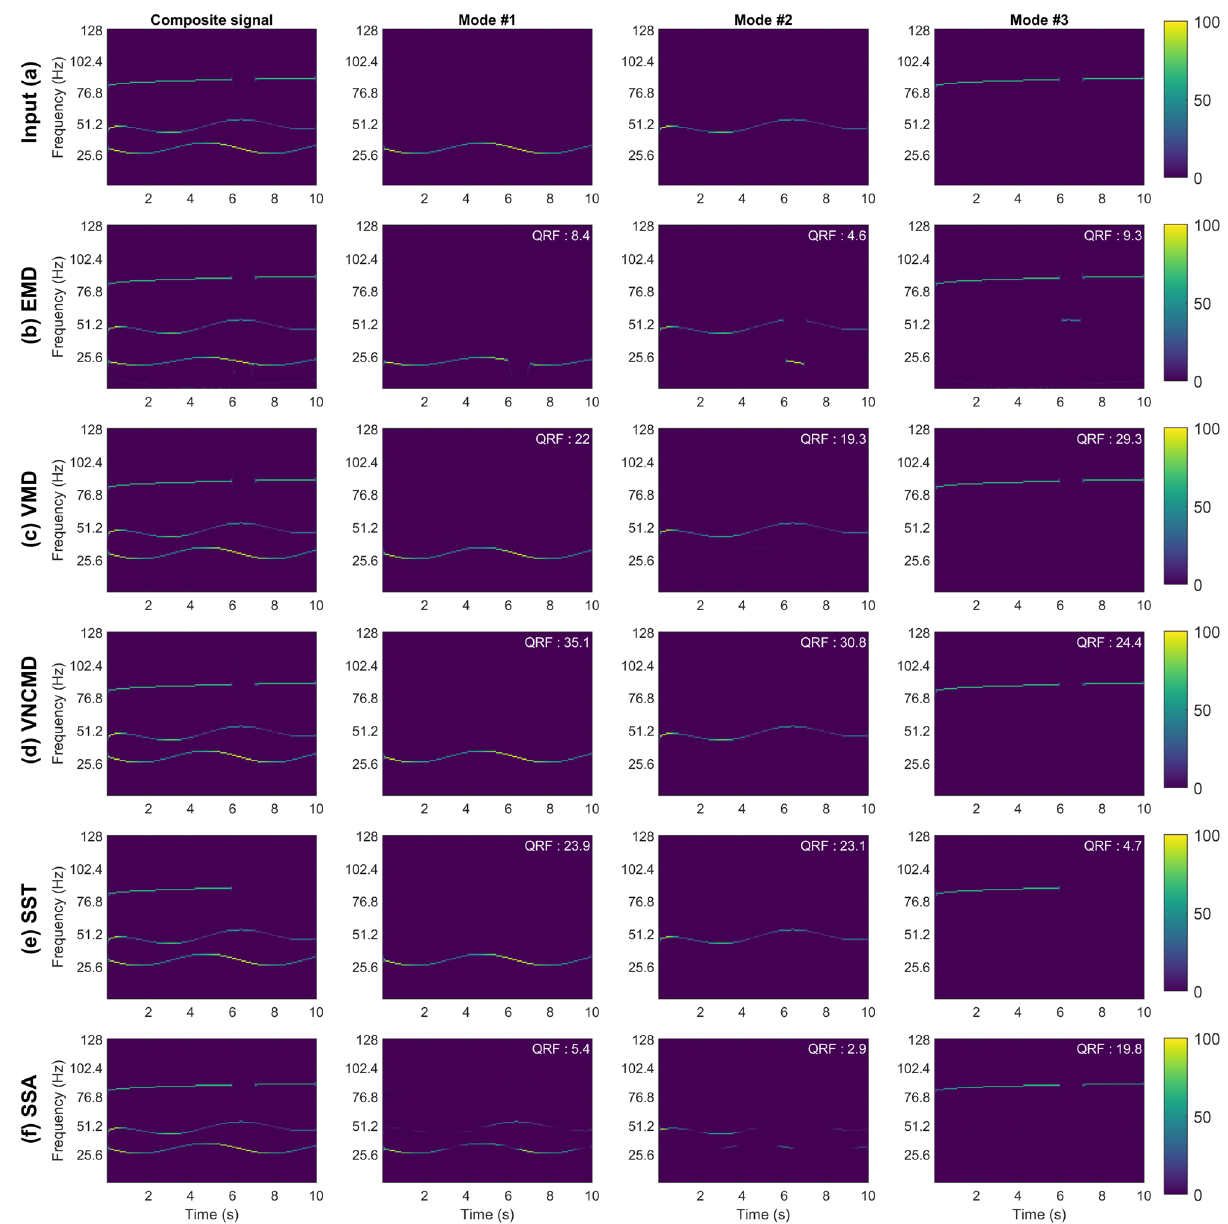
Figure 2. Performance evaluation of SD and T–F approaches on the narrow-band synthetic signal. Plot ( a ) shows the original input signal with each of its constituent components shown in the same row. Similarly this is done for each method, EMD, VMD, VNCMD, SST and SSA in plots ( b – f ), where the reconstructed signal is shown together with the respective extracted modes. QRF is calculated with respect to the corresponding original signal component and shown in the upper right corner of each T–F